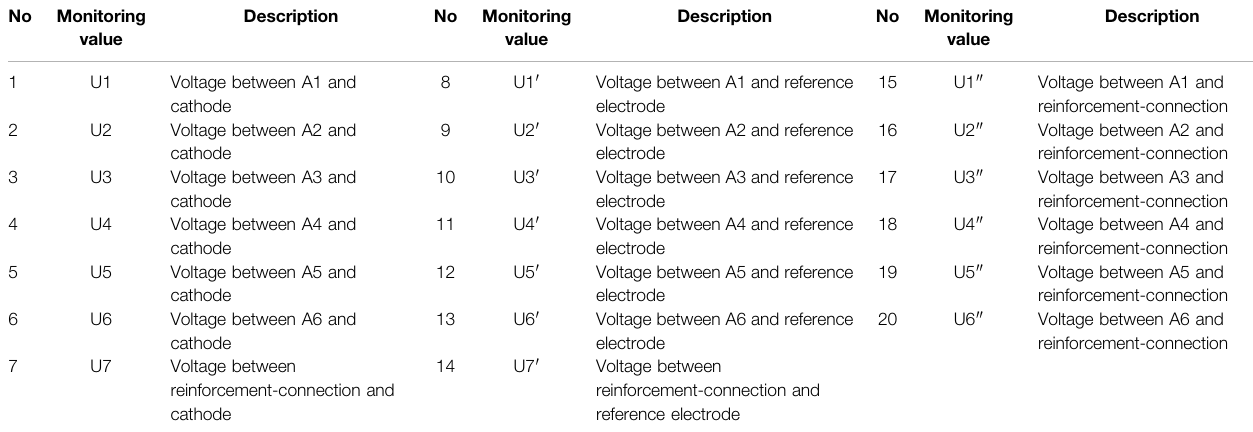
TABLE 1 | Voltage values collected by the anode-ladder